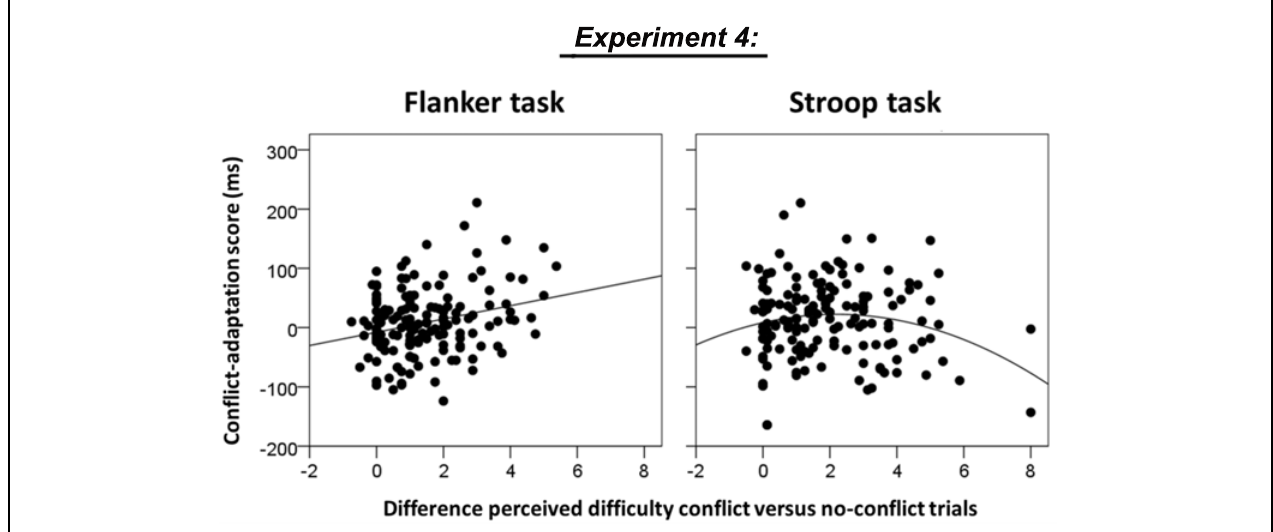
FIGURE 6 | Association between the difference in rated difficulty of conflict minus no-conflict trials and conflict adaptation in Experiment 4 for the flanker task (linear model fit, p = 0.001) and the Stroop task (quadratic model fit, p = 0.049). Please note that the quadratic fit for the Stroop task did not remain significant after removing the two potential outliers with high difficulty